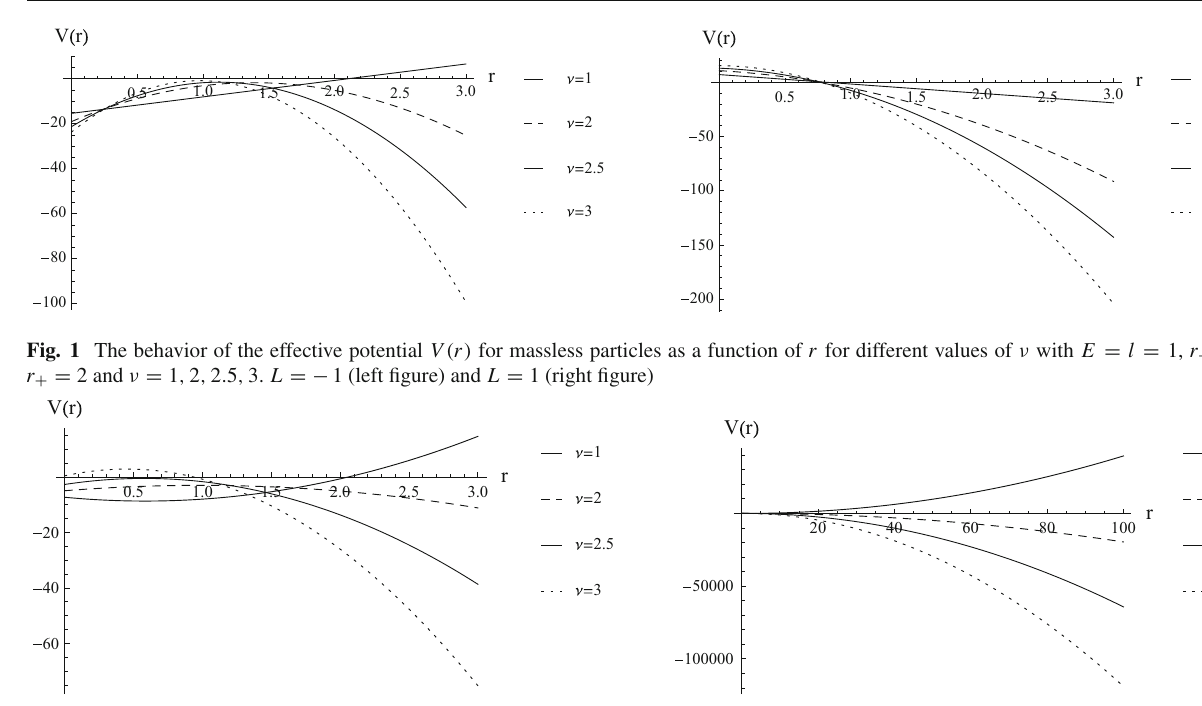
Fig. 2 The behavior of the effective potential V ( r ) for massive par- ticles as a function of r for different values of ν with E = l = 1, L = − 1, r − = 1, r + = 2 and ν = 1 , 2 , 2 . 5 , 3. Left figure shows the